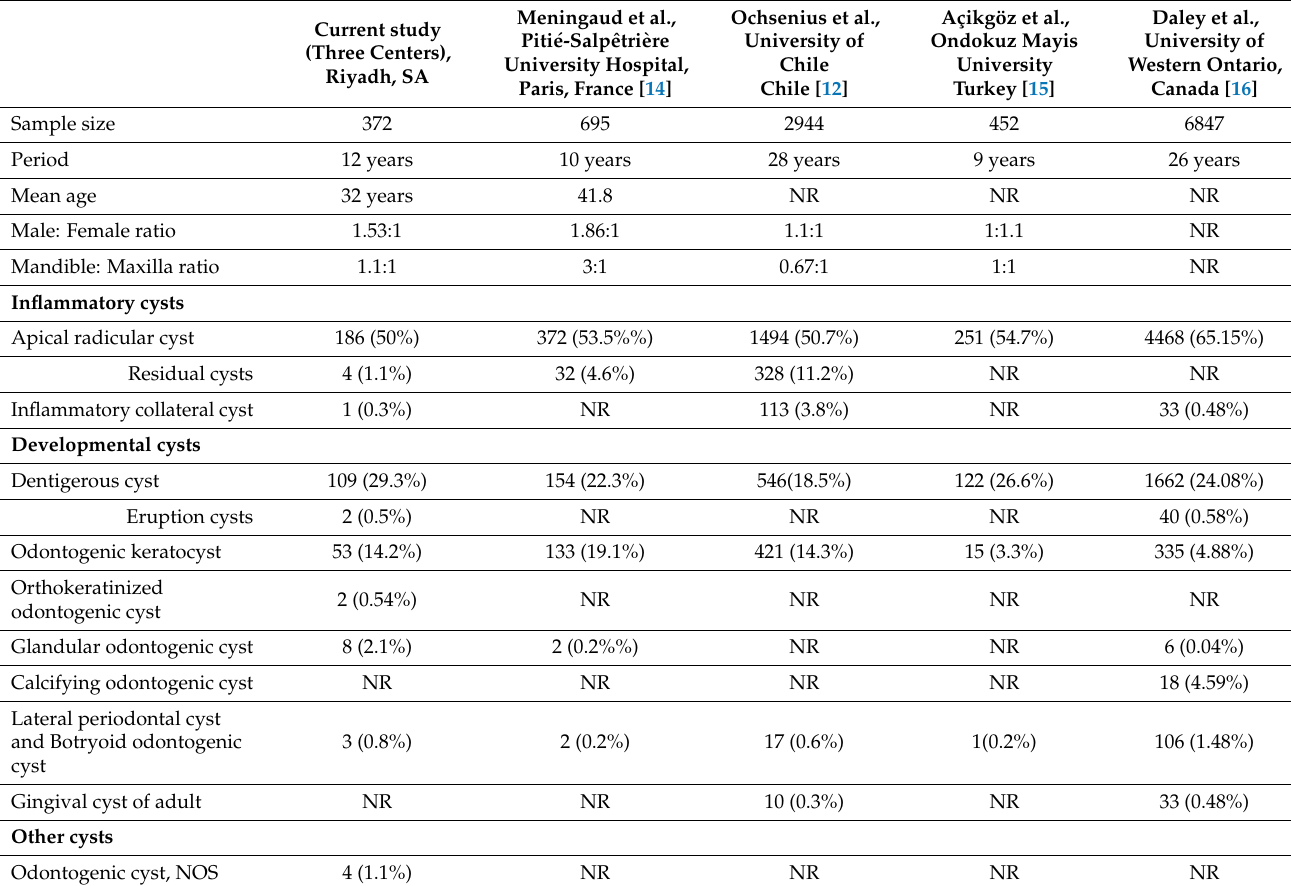
Table 8. Comparison of OC distribution in the current study and selected international